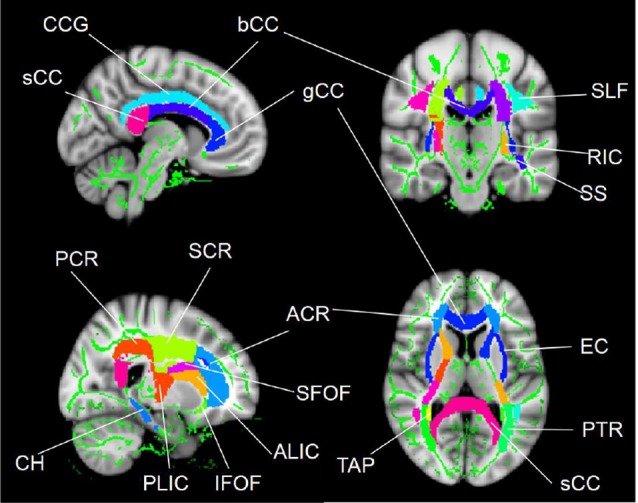
WM tract regions of interest (ROIs) based on the ICBM-DTI-81 WM labels atlas in cerebral regions. Abbreviations for WM tracts can be seen in Supplementary Table S1.